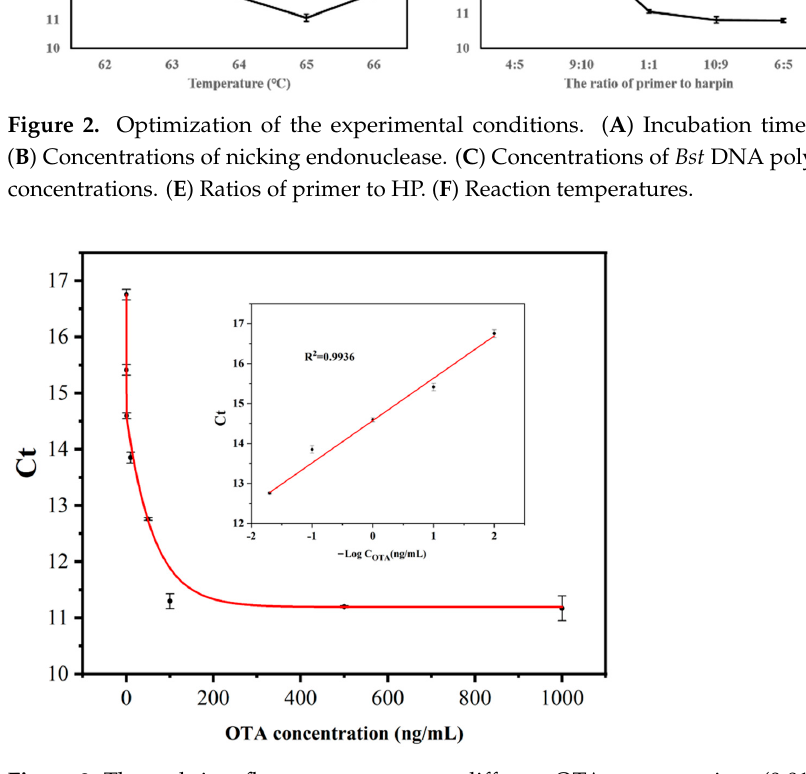
Figure 3. The real-time fluorescence curve at different OTA concentrations (0.01, 0.1, 1, 10, 50, 100, 500 and 1000 ng mL − 1 ). Inset: The relationship between Ct and the negative logarithm of the OTA concentration (0.01–50 ng mL − 1 ). The error bars of Ct values represent three independent tests of the same sample. Table 2. Comparison of the SDA-based fluorescent aptasensor with other technologies based on aptamers for OTA detection.